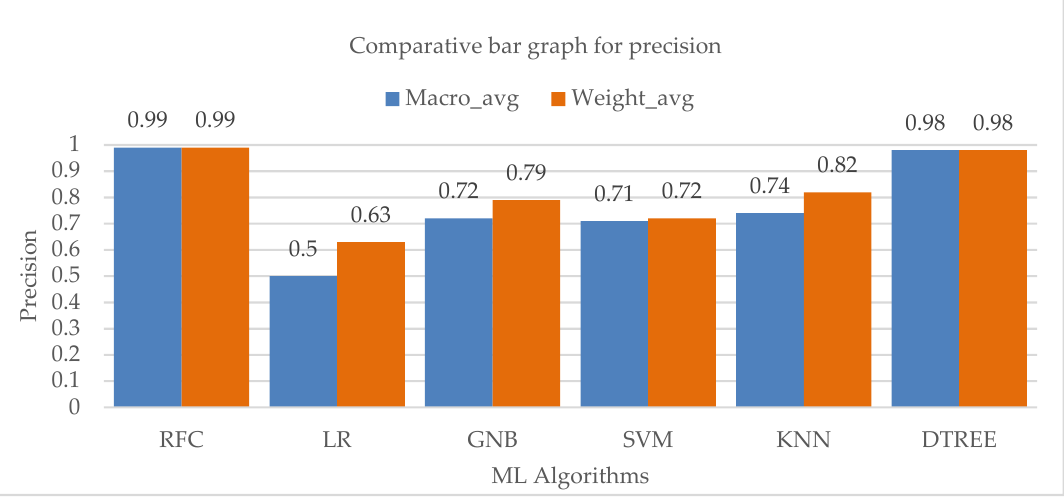
Random-Forest and Decision-Tree algorithms to the overall precision of the entire class.